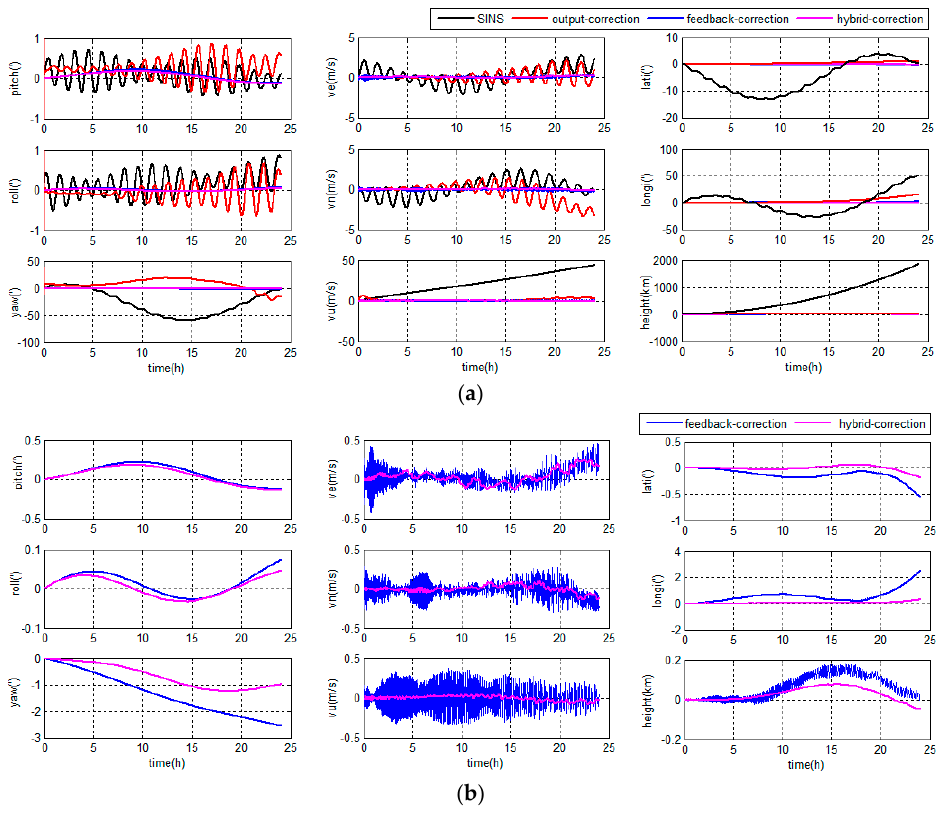
Figure 11. Navigation errors in high latitude regions: ( a ) grid SINS errors and integrated navigation errors; and ( b ) feedback and hybrid correction integrated navigation errors.